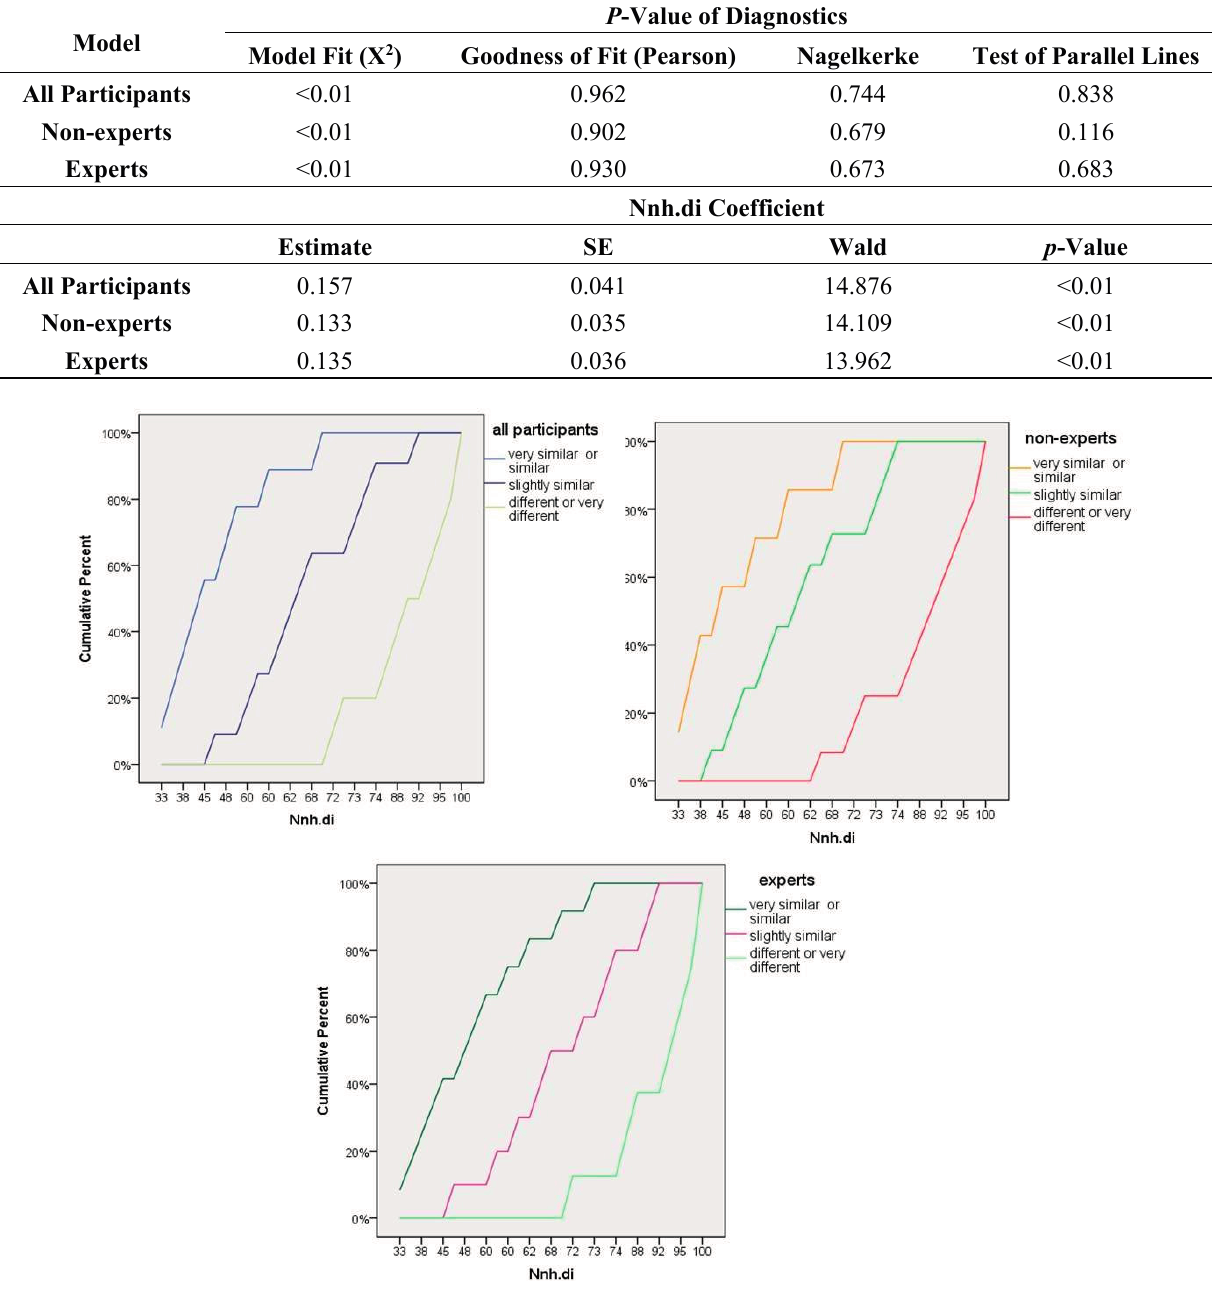
Figure 4. Cumulative percentages of Nnh.di by category of perceived similarity (very similar/similar, slightly similar and different/very different) for each group (all participants, non-experts,